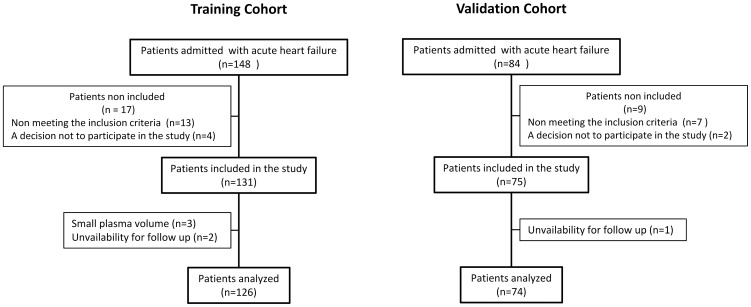
Flow-chart of the study.